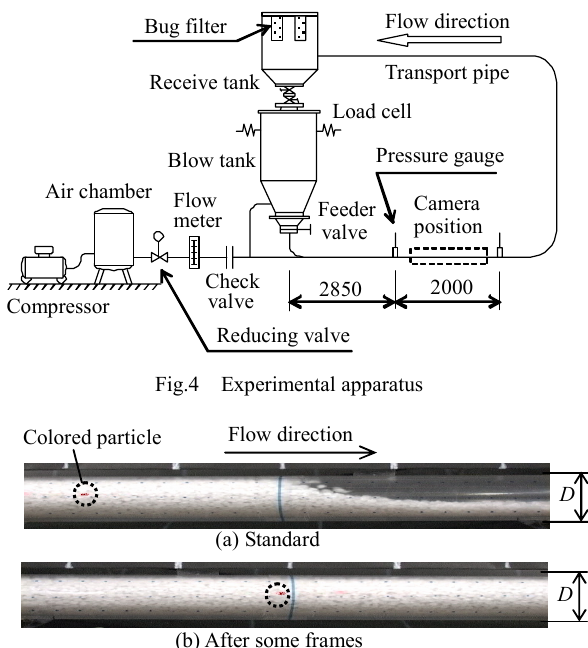
Fig.5 Measurement of particle velocity by digital video